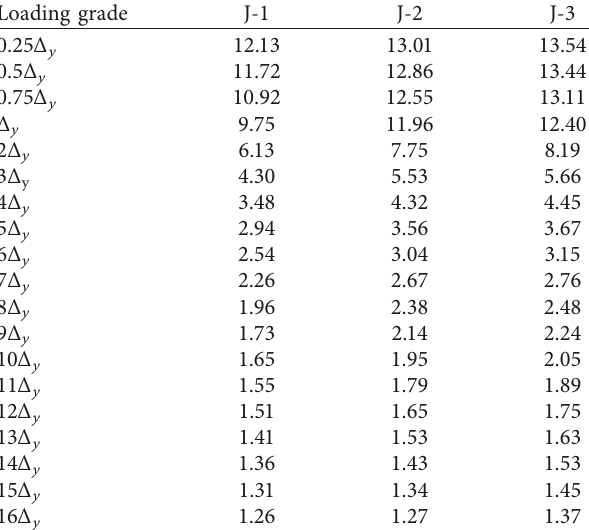
Table 4: Stiffness of the